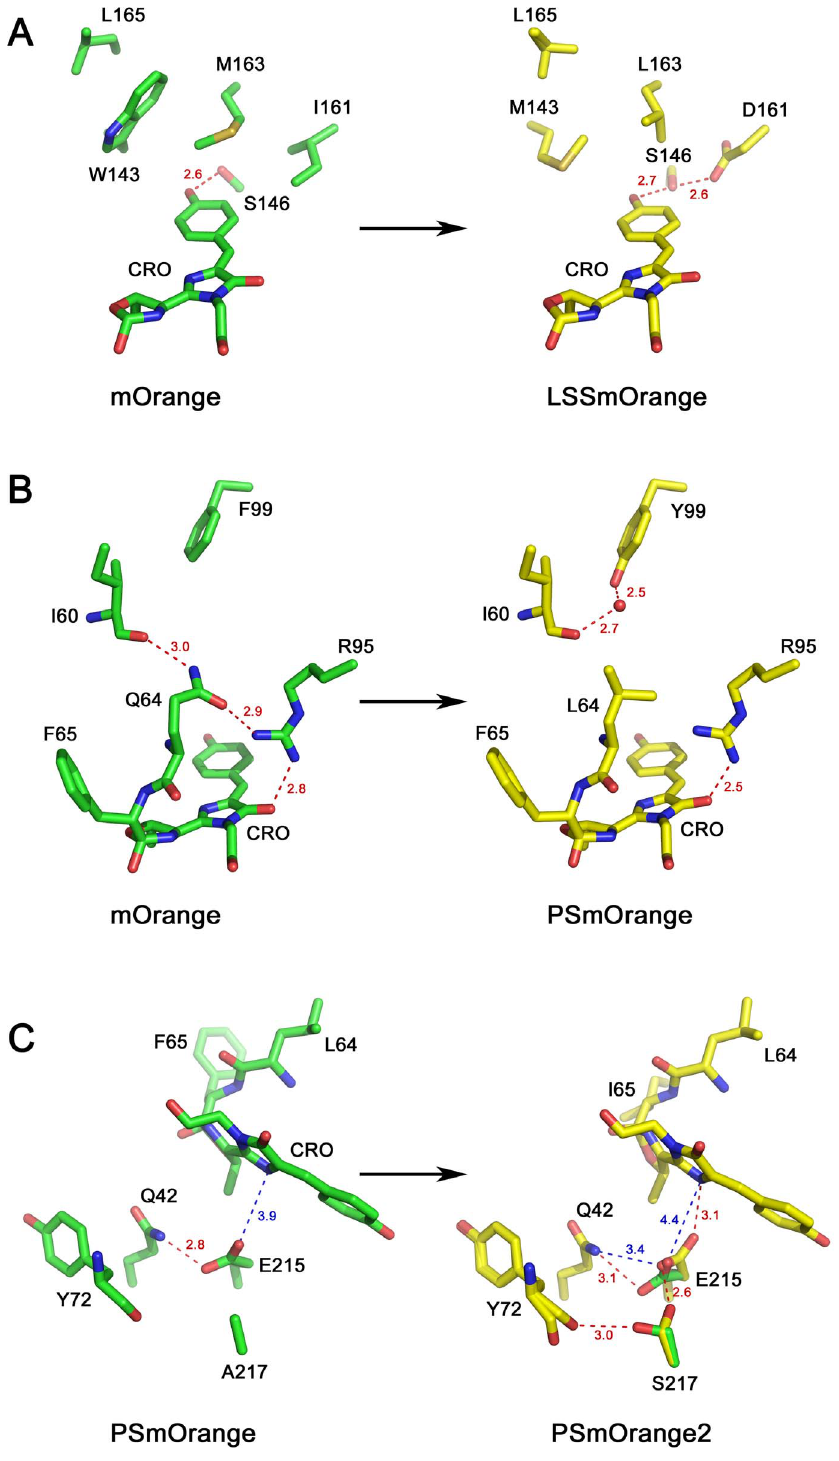
Figure 4. The differences in the immediate chromophore environment between the parental and successor proteins. ( A ) The difference between mOrange and LSSmOrange. ( B ) The difference between mOrange and PSmOrange. ( C ) The difference between PSmOrange and PSmOrange2.